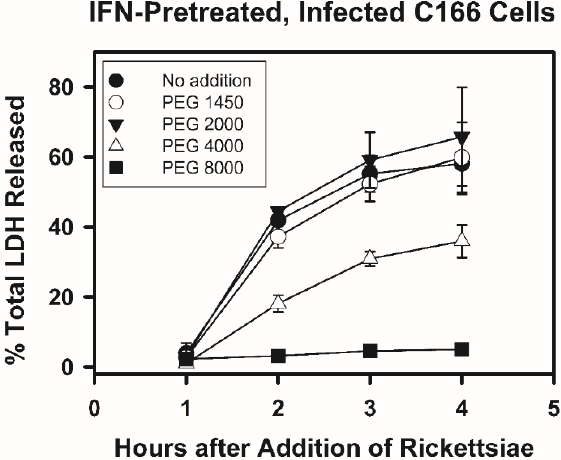
Figure 4. Effect of PEGs of different nominal average molecular weights on the release of lactate dehydrogenase (LDH) from IFN- γ -pretreated C166 endothelial cells after addition of R. prowazekii . PEGs were added to IFN- γ -pretreated and washed cells along with rickettsiae and samples of the culture media were collected for assay of LDH activity at various times. Table 1 provides the number of determinations and shows additional data from these experiments. Table S4 provides the individual data points. For PEG 8000, the values for the standard deviations were within the symbols. PEGs were used at a concentration of 30 mM, except for PEG 8000, which was used at a concentration of 15 mM. At 2 h, 3 h, and 4 h after addition of the rickettsiae, the mean value for the cultures without PEG differed significantly from the mean values for the cultures with PEG 8000 or PEG 4000 ( p < 0.05). Table 1. Effect of PEGs on R. prowazekii -induced release of LDH by interferon-treated C166 cells a .